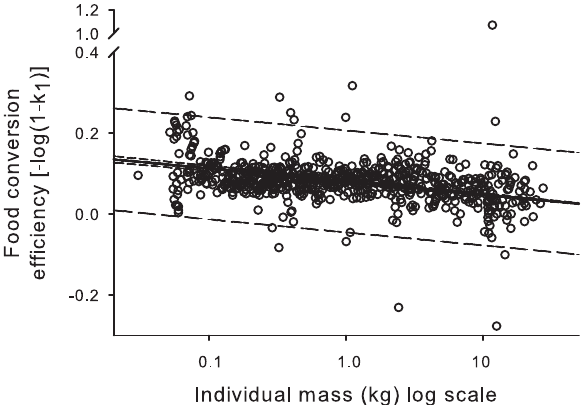
Figure 1. Log-log transformation of food conversion efficiency ‘K 1 ’ versus an individual’s mass (kg) showing the best-fit curve from GLM with 95% confidence bands (short-dashed lines) and 95% prediction bands (long-dashed lines).